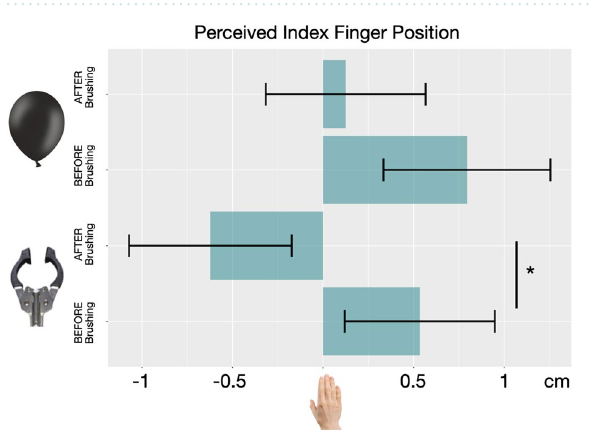
Figure 1. Study summary. Experiment 1 (N = 16) aimed to assess whether embodiment for a tool can be induced with an RHI-like setup. As a control, we used a balloon as in Ma and Hommel, 2015. We measured brushing-induced proprioceptive drift of the index finger and subjective feelings of embodiment using a questionnaire. Experiment 2 (N = 40) tested tool embodiment in a larger sample and investigated the role of functional use of the tool. The same measures as in Experiment 1 were used. Experiment 3 (N = 32) investigated the physiological correlates of embodiment, measuring skin conductance responses after threat to the embodied tool.